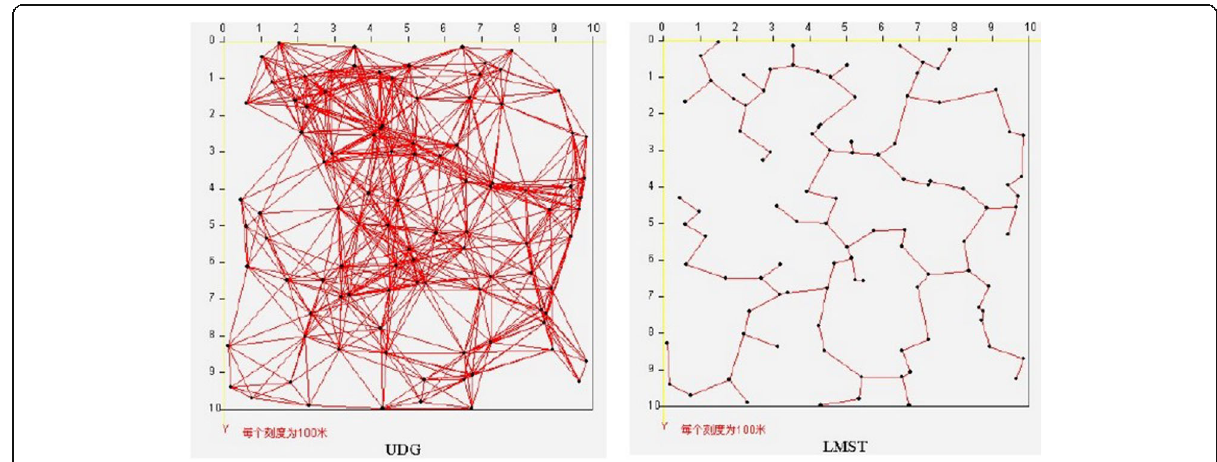
Fig. 1 Topology diagram generated by UDG algorithm and LMST